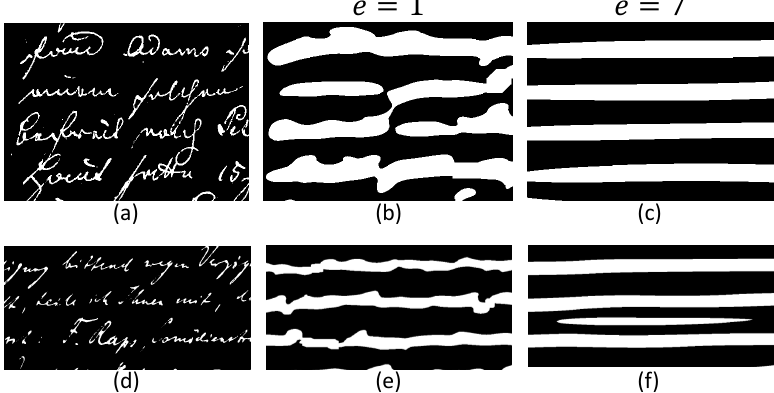
Figure 11. Effect of elongation rate ( e ) on blob lines. ( a , d ) are two different binary input images. ( b , e ) are the resultant blob lines when e = 1. ( c , f ) are the resultant blob lines when e = 7. As e decreases the spatial context is missed and two touching text lines are considered as one ( b ). As e increases the unrelated spatial context is grasped and a spurious blob line is generated ( f ). Table 3. Effect of elongation rate on performance and time. e Precision Recall F-measure Time